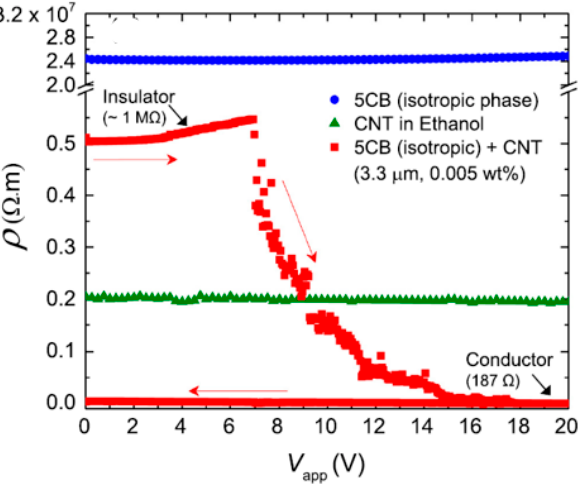
Figure 10. The field-induced resistivity modulation in 3.3 µ m cells for (i) pure 5CB in the isotropic phase at T = 40 °C ( the blue circle ); (ii) CNT (0.005 wt. %) in ethanol at room temperature ( the green triangle ), and (iii) 5CB/CNT (0.005 wt. %) in the isotropic phase at T = 40 °C ( red square ) [57].